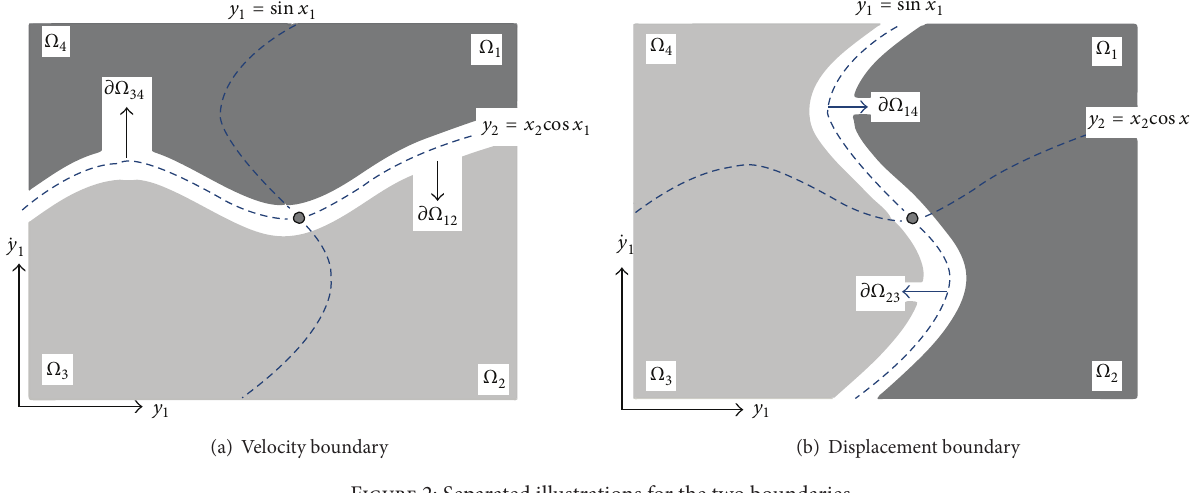
Figure 2: Separated illustrations for the two boundaries.